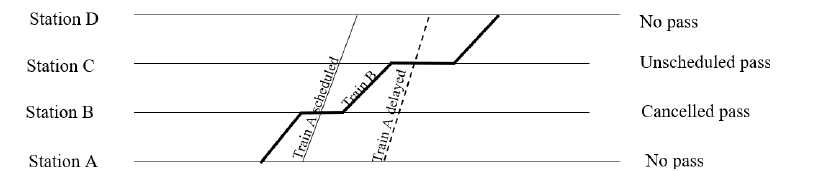
Figure 2. Scenario with different types of train